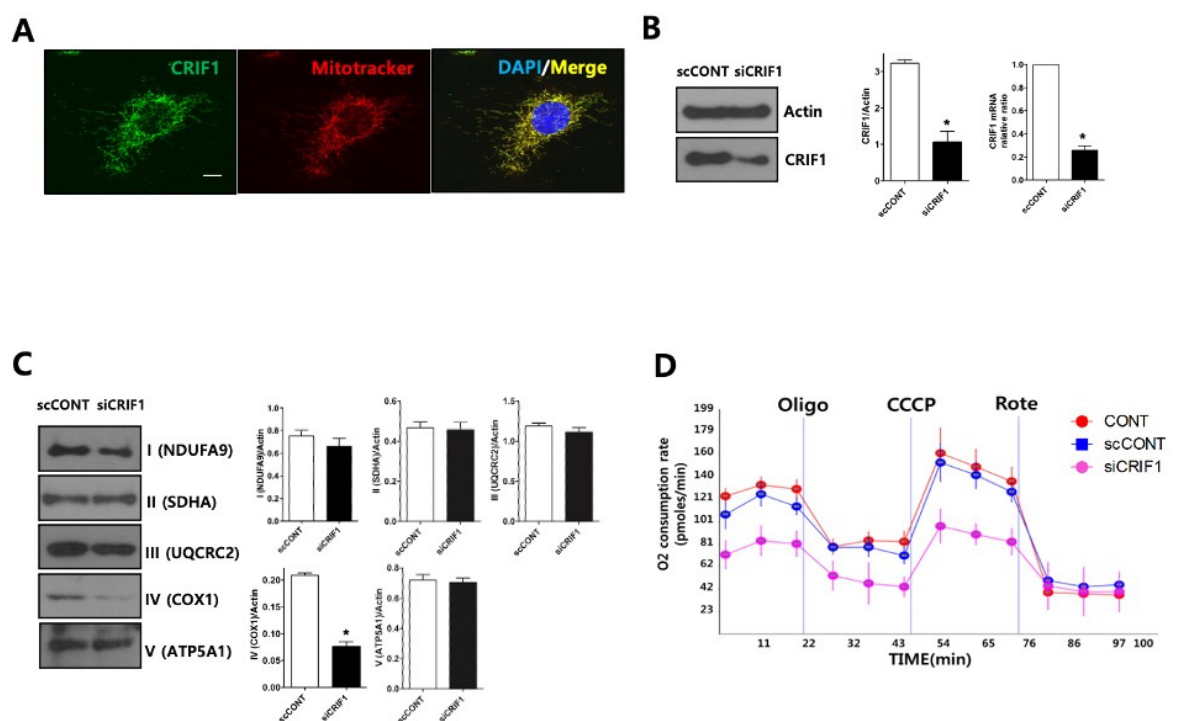
Figure 5. Deletion of CRIF1 causes mitochondrial dysfunction in podocytes. ( A ) Immunofluorescent staining of endogenous CRIF1 in an immortalized mouse podocyte. MitoTracker Red and DAPI were used to stain the mitochondria and nucleus, respectively. Scale bar, 20 µ m. ( B ) Immunoblot analysis (left and middle panels) of CRIF1 protein expression and qRT-PCR analysis of Crif1 mRNA expression in podocytes transfected with a scrambled control siRNA (scCONT) or a CRIF1-specific siRNA (siCRIF1). The expression levels of CRIF1 protein and Crif1 mRNA were normalized to those of actin and GAPDH, respectively. Data are represented as the mean ± SD of n = triple replicates. ( C ) Immunoblot analyses of mitochondrial protein complexes I–IV. The expression levels of the complexes were normalized to those of actin. Data are represented as the mean ± SD of n = triple replicates. ( D ) The OCRs in non-transfected (CONT), control siRNA-transfected (scCONT), and CRIF1-specific siRNA-transfected podocytes after the addition of oligomycin (Oligo; 2 µ g/mL), CCCP (10 µ M) and rotenone (Rote; 1 µ M). * p < 0.05 ( B , C ) by Student’s t -tests.